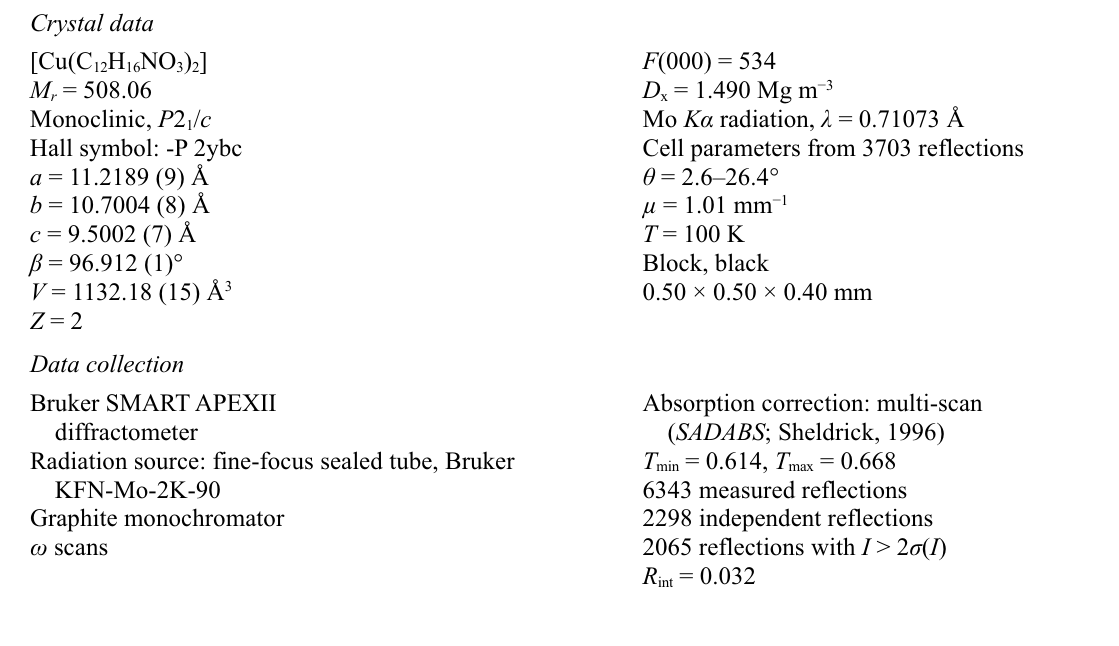
A packing diagram of the title compound along the c axis. Hyrogen bonds are shown as dashed lines. Bis{2-methoxy-6-[(3-methoxypropyl)iminomethyl]phenolato- κ 2 N, O 1